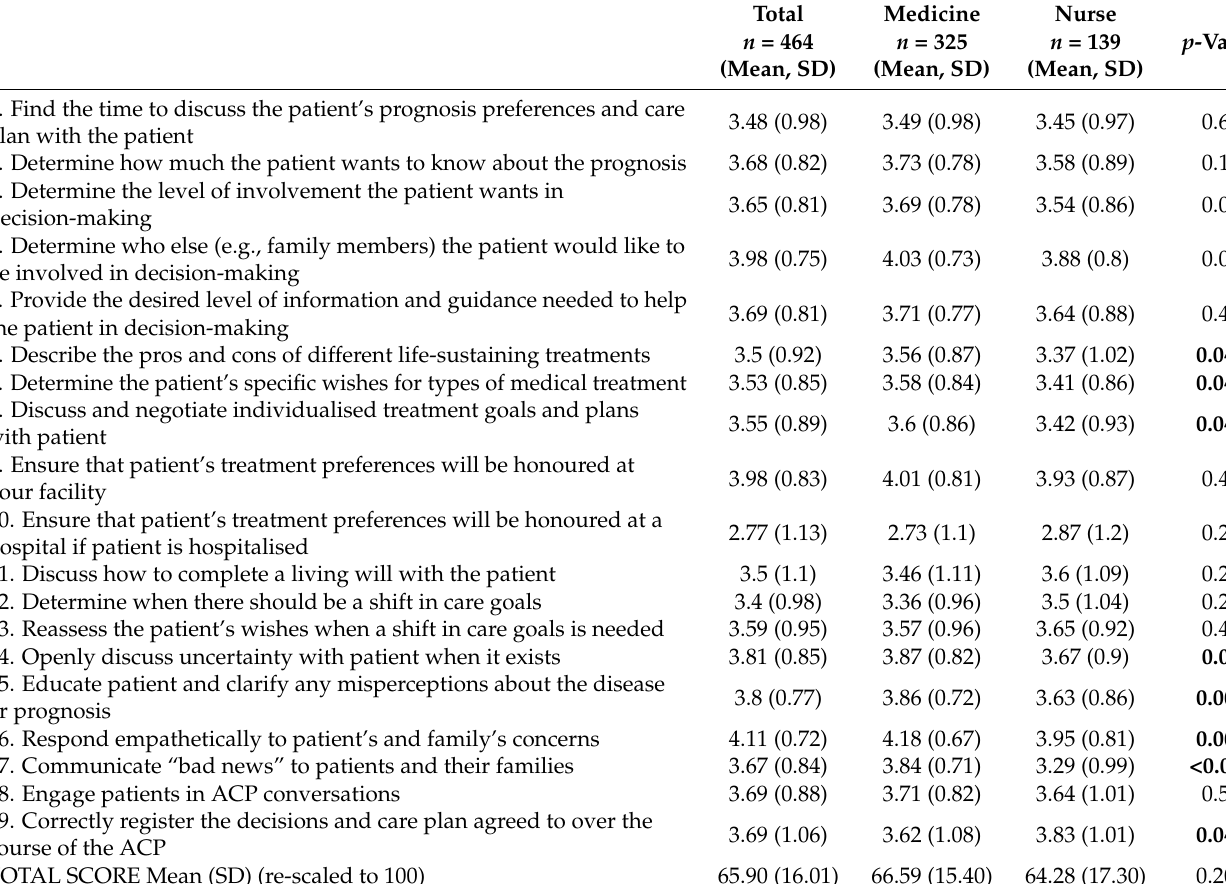
Table 4. Relation between the ACP-SEs 1 and